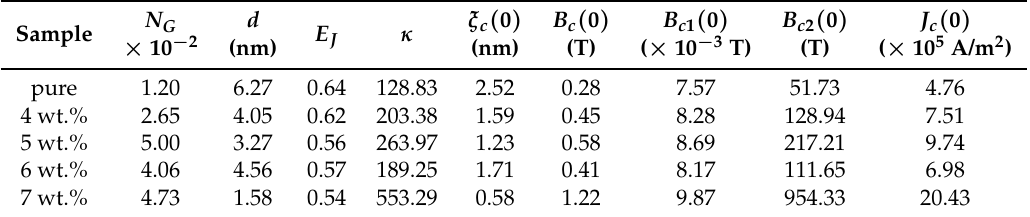
Table 3. Superconducting parameters of FeSe samples with silver addition determined from the fluctuation-induced conductivity (FIC) analysis.